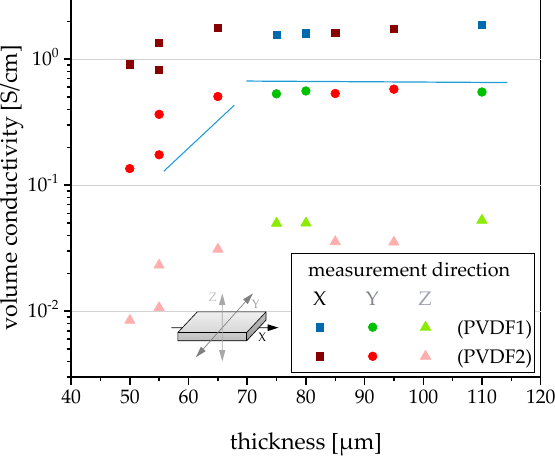
Figure 8. Direction-dependent volume conductivity in dependence on film thickness for PVDF/1 wt % b-MWCNTs + 3 wt % CB composites (blue lines are only for guiding the eyes).